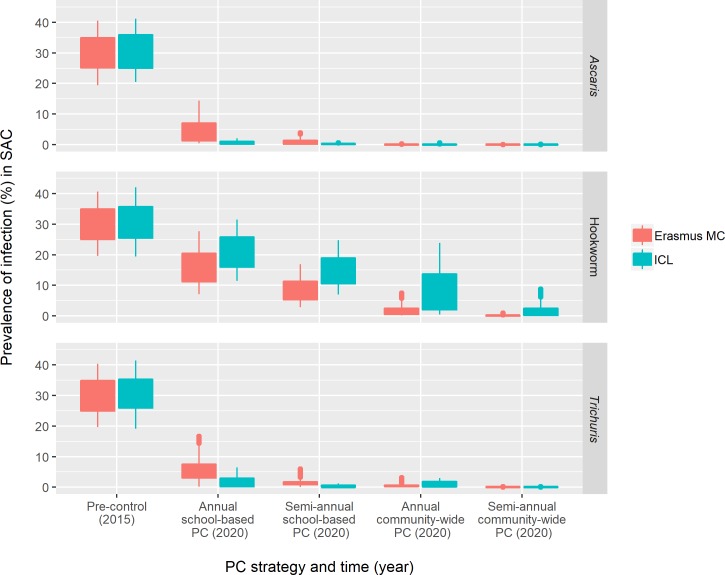
Box-plots of model-predicted prevalences of infection among school-age children (SAC) at the district level before and after school-based PC.Prevalence is measured in all SAC living in each district at two time points: at baseline (2015) and after 5 years of PC (2020). Every randomly generated district has mean baseline prevalence between 20 and 40% (0.01 increments). School-based PC is assumed to cover children of age 2–15 (preSAC and SAC) at 75% and community-based PC is assumed to cover the entire population of age >2 at 75% (allowing for random variation in coverage between individual villages within the district). S1 Fig holds similar plots for results stratified by mean baseline prevalence in districts (20–30% and 30–40%).